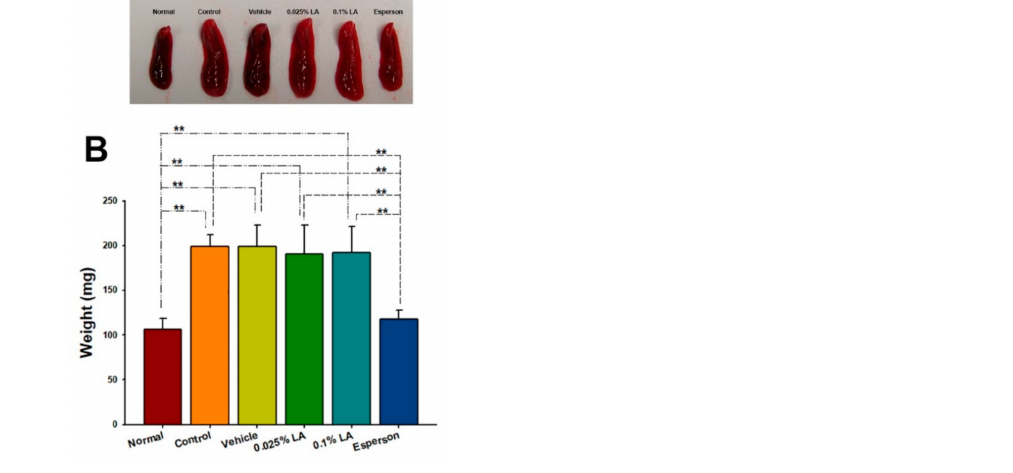
Figure 4. DXM inhibited spleen enlargement in IMQ-induced psoriasis-like mice. ( A ) Morphology ( B ) Measurement of spleen weight. ** p < 0.01.